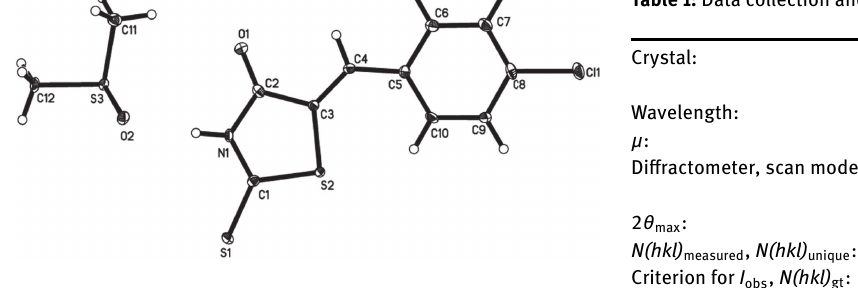
Table 1: Data collection and handling.